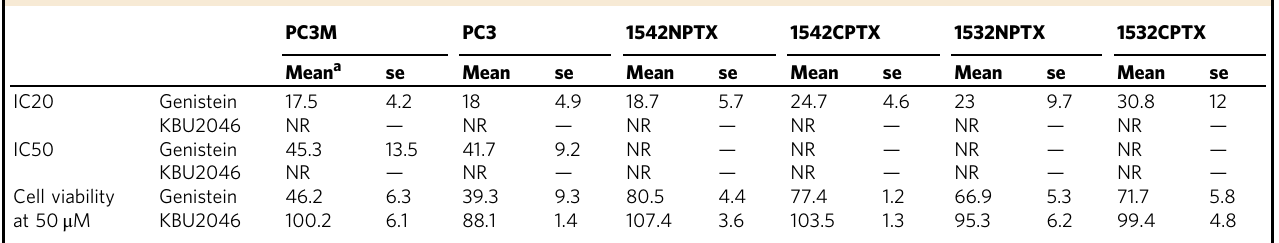
Table 1 Effect of KBU2046 and genistein on human prostate cell